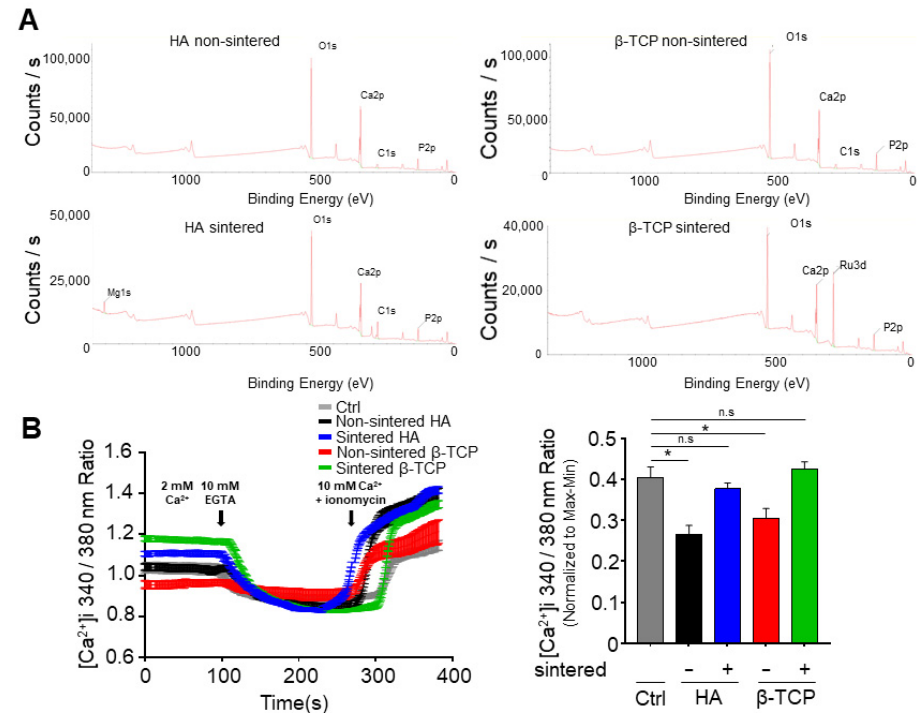
Figure 2. ( A ) X-ray photoelectron spectroscopy (XPS) spectra of sintered and non-sintered HA and β - TCP; ( B ) Intracellular calcium measurements from cells incubated with the sintered and non-sintered bioceramics. The bar graph shows values presented as a mean ± the standard error of the mean (SEM.). The values were also normalized to those of the control sample. The results were compared using the one-way analysis of variance (ANOVA) method. * p < 0.05; n.s = not significant.